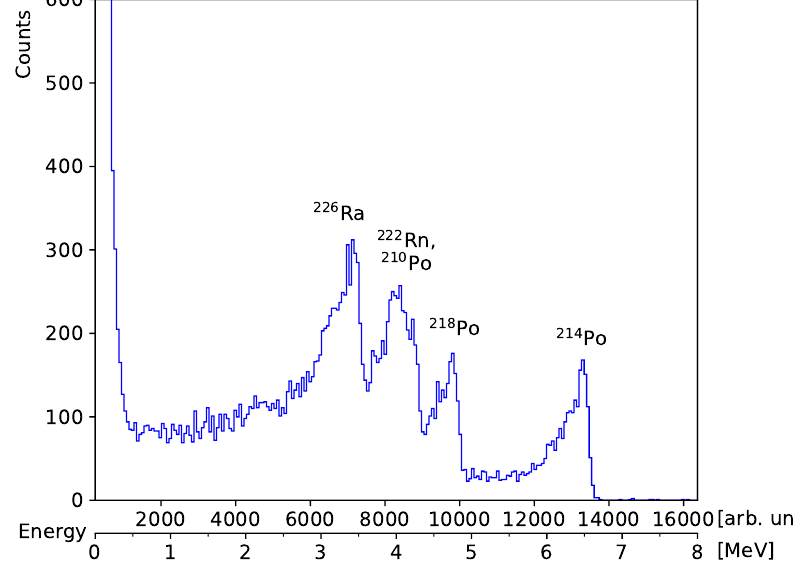
Figure 10. Energy histogram of a radium painted watch hand recorded with the DIY particle detector. Four peaks are clearly identified, even without guidance by a simulation since most characteristic α -energies are further apart in this measurement than the straggling broadens